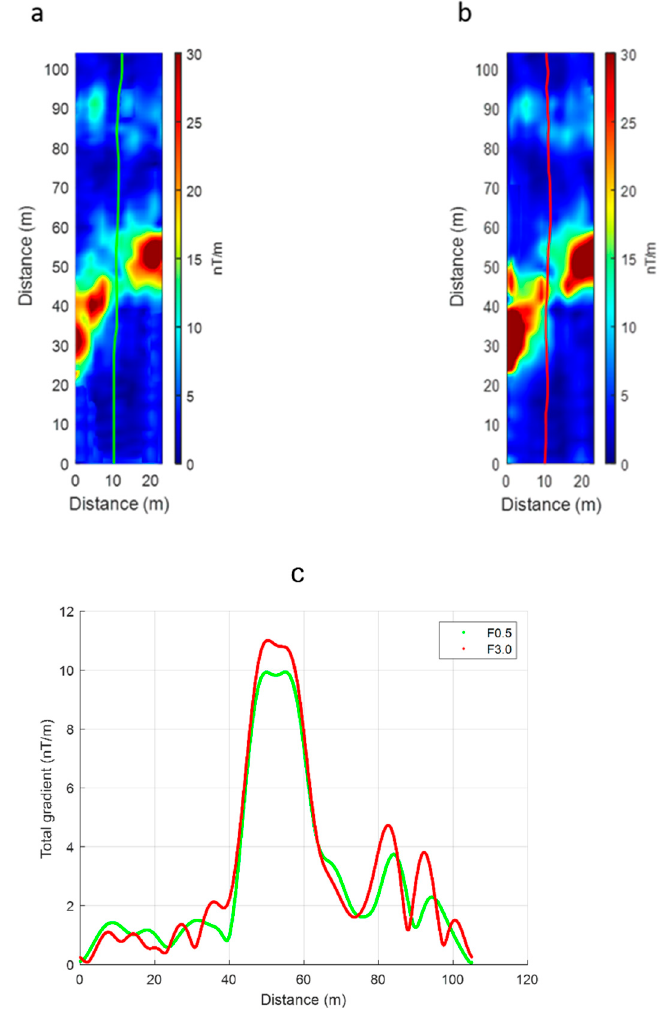
Figure 9. Total gradient maps relative to filtered F0.5 ( a ) and F3.0 ( a ) UAV datasets; ( c ) total gradient computed along a filtered profile (located by green and red lines in ( a , b )). The green line refers to the F0.5 dataset, and the red line refers to the F3.0 dataset.